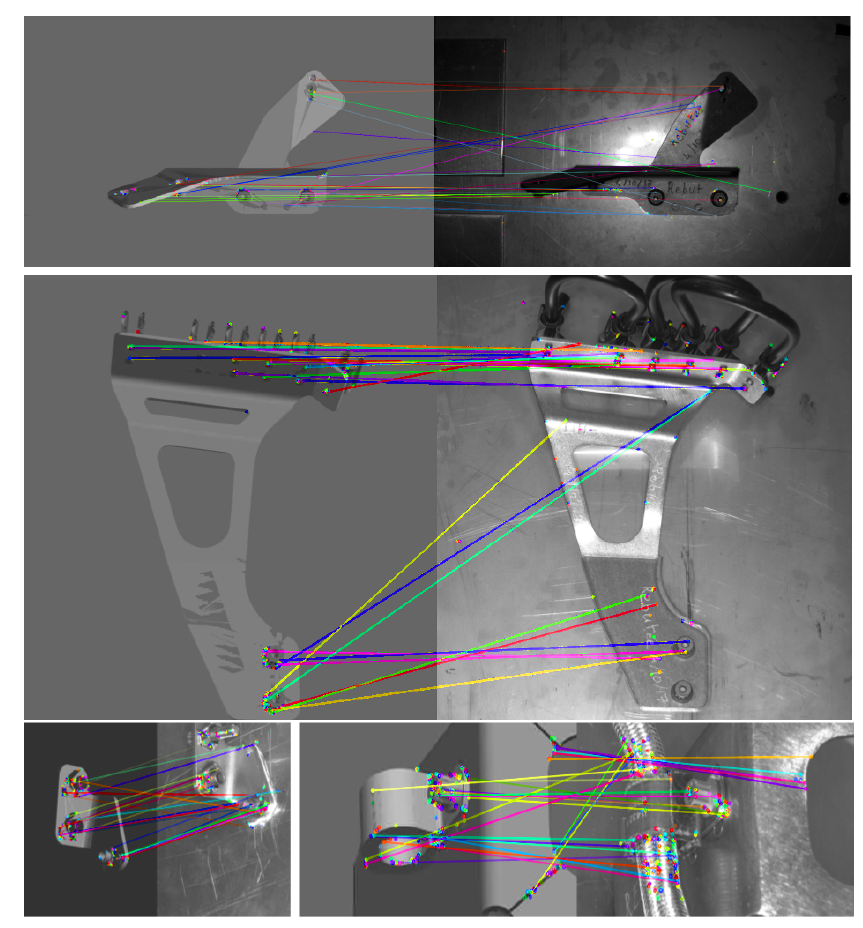
Figure 8. Four image pairs showing nearest neighbor matching between renders and real images. In each pair, the left image is a simple render generated for the real image to its right. Only a subset of matches have been shown for clarity.